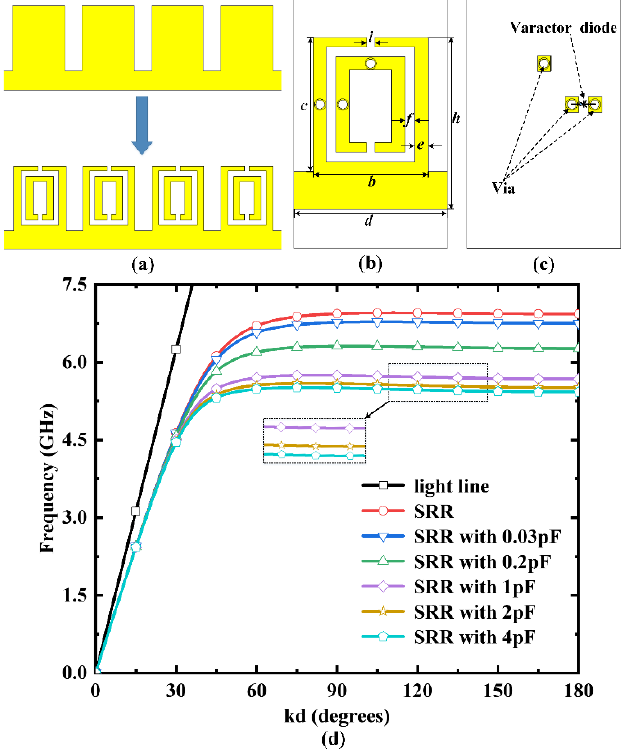
Figure 1. The unit structure of the programmable SRR and dispersion curves. ( a ) Evolution of the SRR structure. ( b ) The top view. ( c ) The bottom view. ( d ) The dispersion curves.